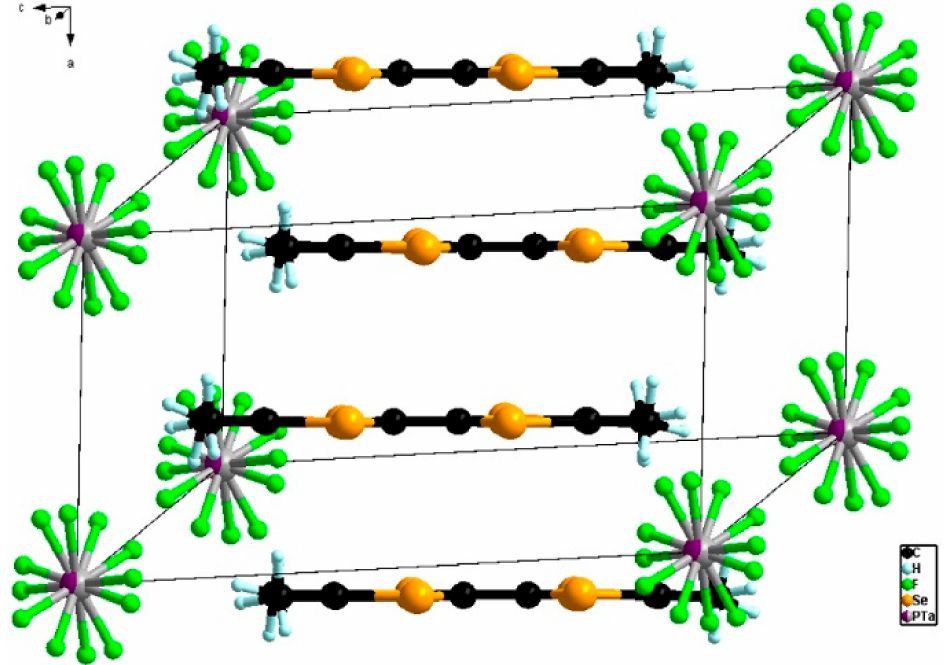
Figure 3. Packing of TMTSF donors along a in the structure of (TMTSF) 2 (TaF 6 ) 0.44 (PF 6 ) 0.56 . The fluorine atoms were disordered over two